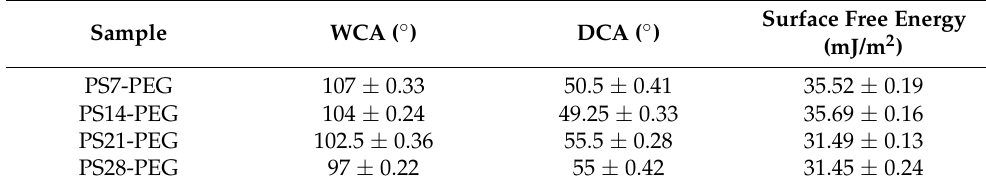
Table 2. WCA and DCA and surface free energy of PS- hydrogel samples.